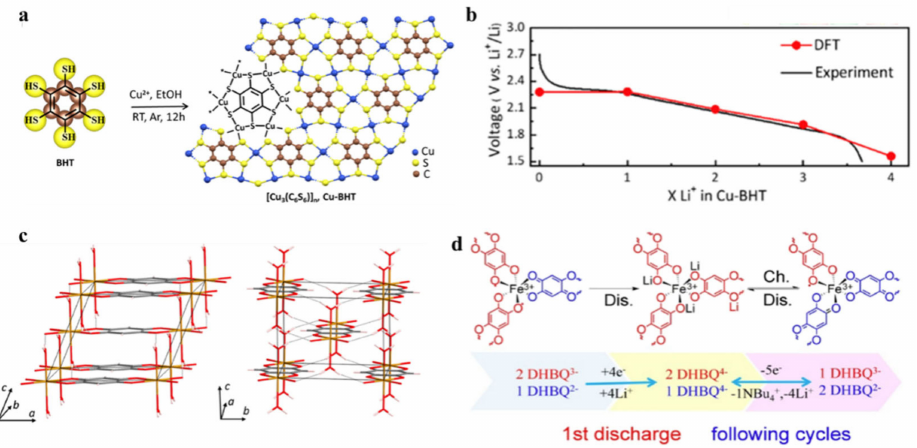
Figure 9. ( a ) Synthesis process of the Cu–BHT C-MOF, ( b ) experimental and theoretically predicted DFT voltage curves for the Cu–BHT C-MOF cathode in the voltage range of 1.5 to 3.0 V (versus Li + /Li). Reproduced with permission from Ref. [84]. Copyright 2020 ACS. ( c ) Perspective view of the crystal structure of Fe(DHBQ)–(H 2 O) 2 along the b- and a-axes. Reproduced with permission from Ref. [101]. Copyright 2021 ACS. ( d ) (NBu 4 ) 2 Fe 2 (DHBQ) 3 reaction mechanism during charge